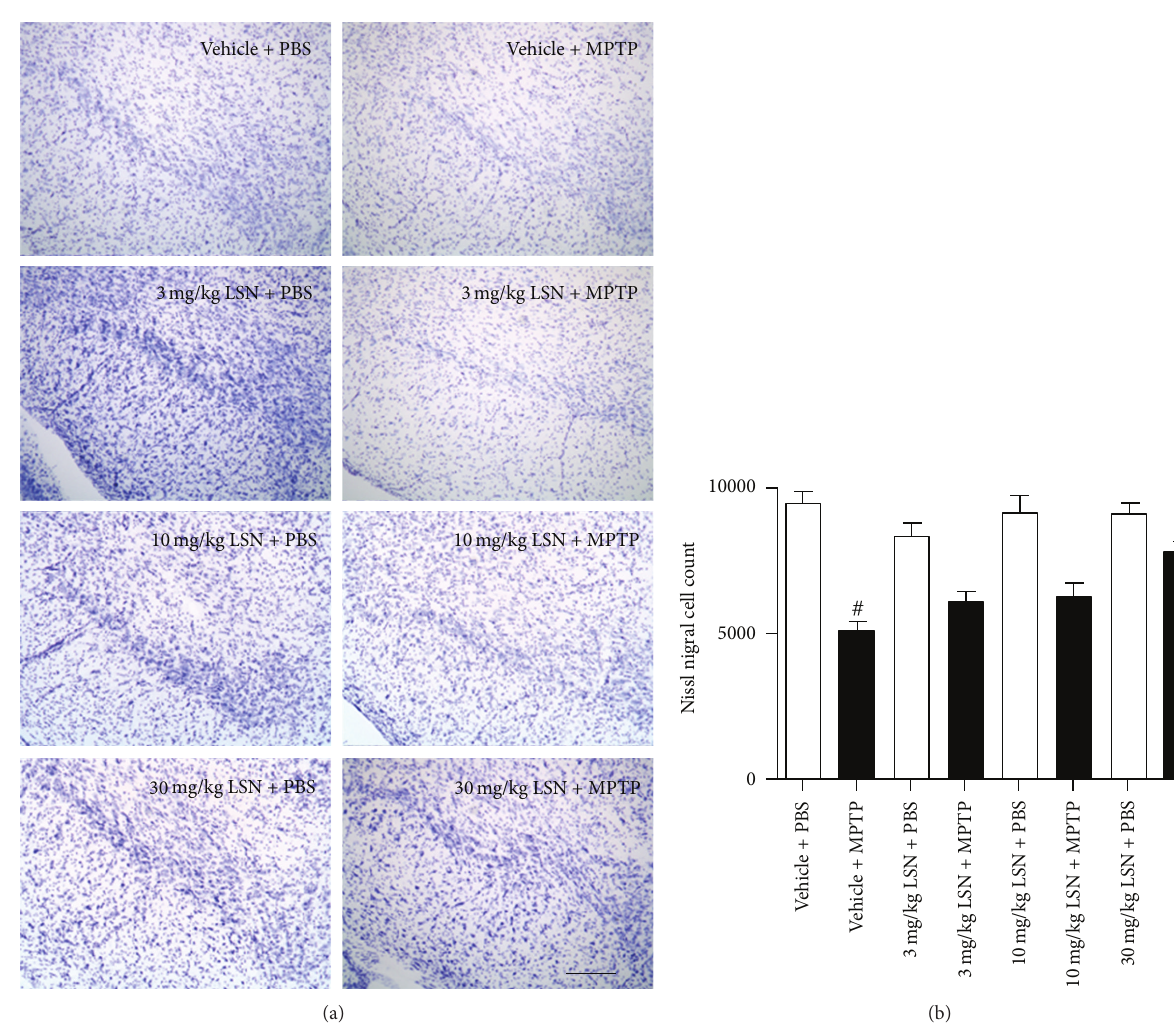
Figure 2: LSN862 (LSN) induced neuroprotection against MPTP not upregulation of the dopaminergic phenotype. Mice were treated with MPTP or PBS and LSN doses or vehicle and euthanized 21 days later. (a) Coronal images at the level of the substantia nigra (SN) stained for Nissl. Scale bar = 100 𝜇 m. (b) Stereological cell quantification of Nissl positive SN cells (mean ± SEM; 𝑛 = 4 – 7 per group). ANOVA (Fisher’s